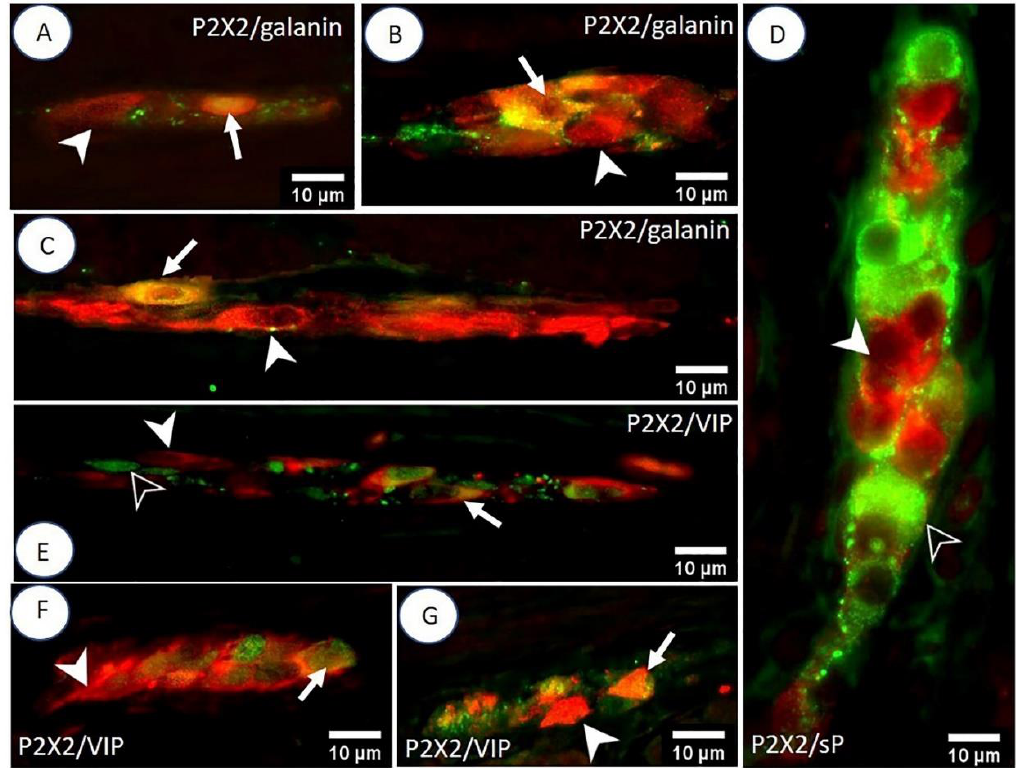
Figure 3. Double IHC staining of the porcine small intestine for P2X2 receptors and selected biologically active substances. The photos ( A – C ) show the MP, ISP, and OSP (respectively) of the duodenum. The arrow indicates P2X2-IR/galanin-IR neurons and the arrowhead indicates P2X2-positive/galanin-negative neurons. Micrograph ( D ) shows the lack of P2X2 co-localization with sP in the OSP of the ileum. The arrowhead indicates a P2X2-positive/sP-negative neuron, and the empty arrowhead indicates a P2X2-negative/sP-positive neuron. Photos ( E – G ) illustrate P2X2/VIP immunoreactivity in the MP, ISP, and OSP (respectively) of the jejunum. The arrow indicates P2X2-IR/VIP-IR neurons, the arrowhead indicates P2X2-positive/VIP-negative neurons, and the empty arrowhead indicates a P2X2-negative/VIP-positive neuron.